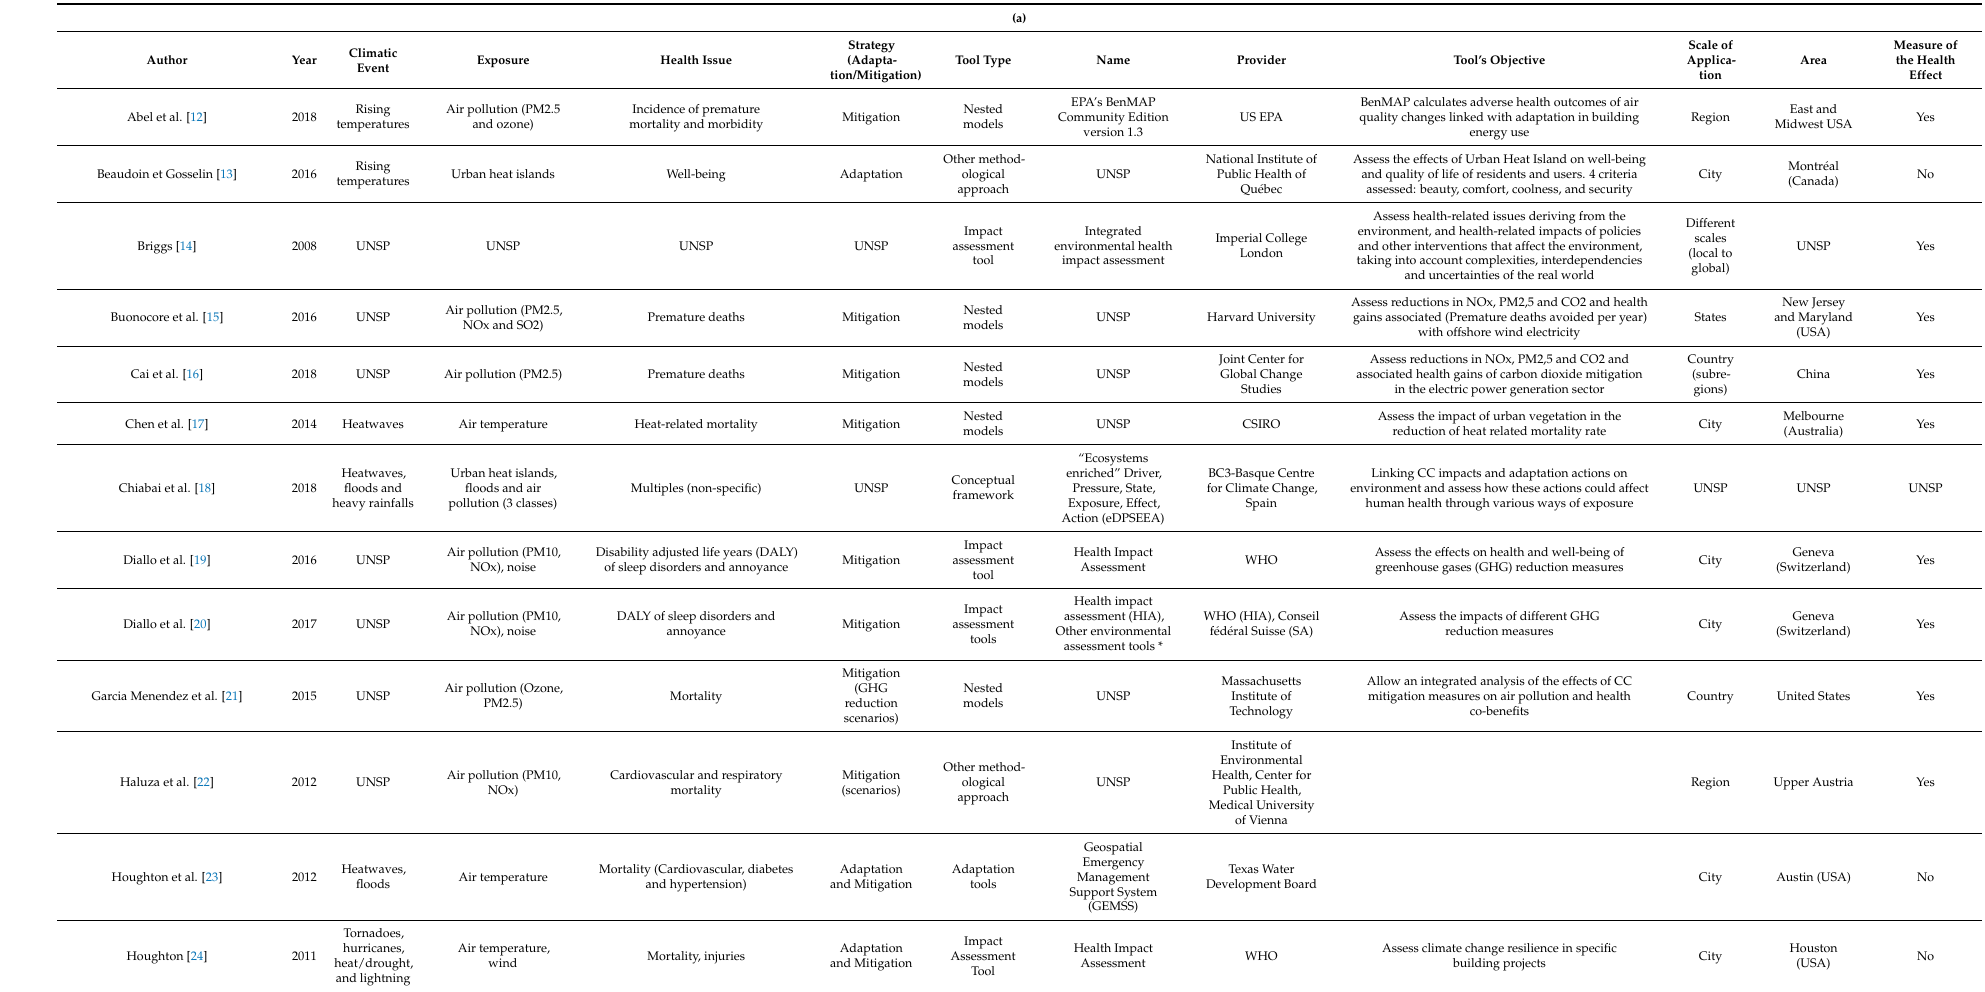
Table 2. ( a ) Synthesis of tools from the selected articles: scientific literature. ( b ) Synthesis of tools from the selected articles: grey literature.